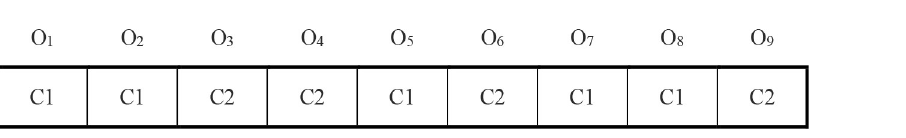
Fig 1. Example of a candidate solution represented by a label-based representation.